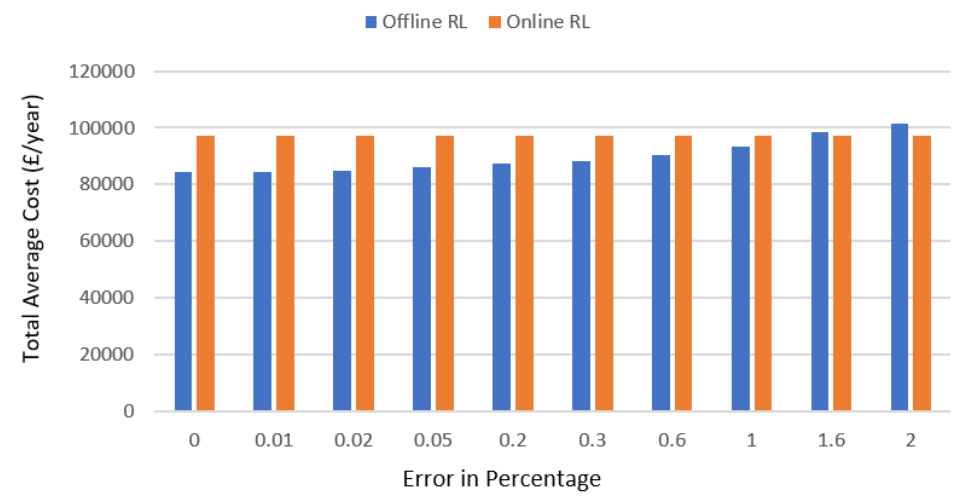
Figure 13. Performance of online vs. offline RL in terms of average total cost per year.